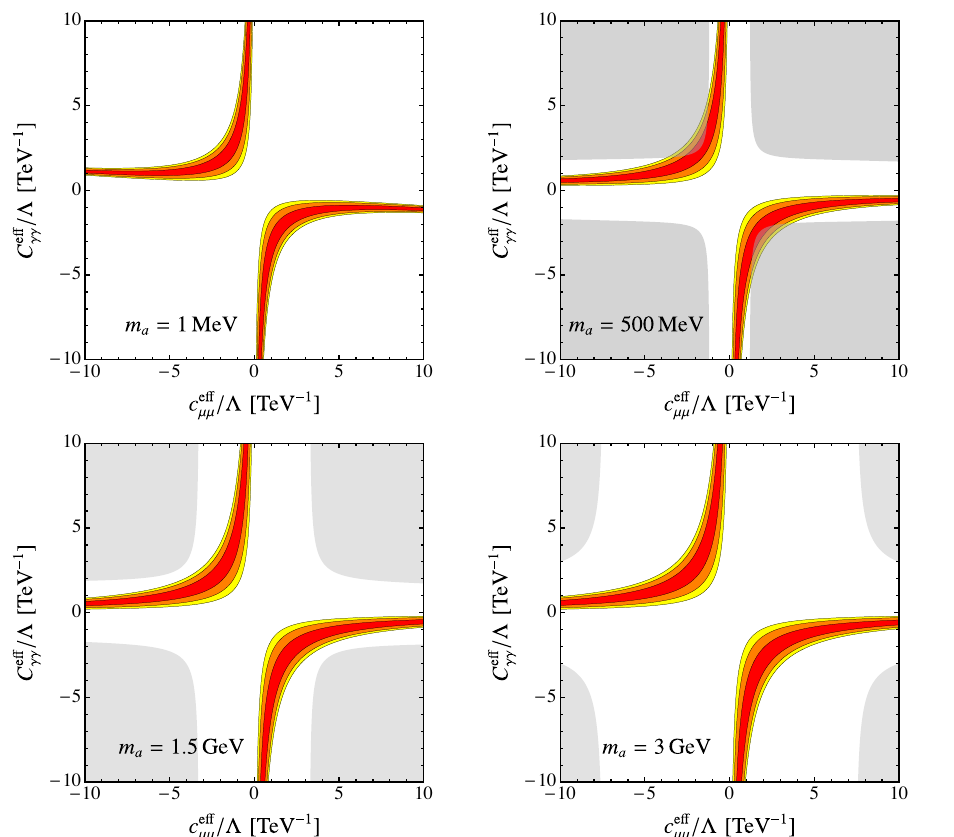
Figure 6 . Regions in ALP coupling space where the experimental value of ( g at 68% (red), 95% (orange) and 99% (yellow) con(cid:12)dence level (CL), for di(cid:11)erent values of m a . We assume K a ((cid:3)) = 0 at (cid:3) = 1 TeV and neglect the tiny contribution proportional to C (cid:13)Z . For (cid:22) m a > 2 m (cid:22) , the gray regions are excluded by a dark-photon search in the e + e (cid:0) channel performed by BaBar